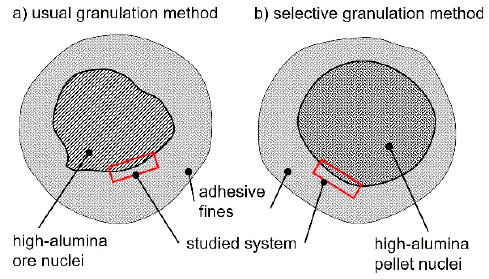
Figure 1. Schematic drawing of sinter granule with alumina-rich nuclei.